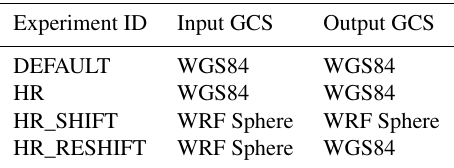
Figure 6. Flowchart for transforming and generating new model input data. Table 2. Shown below is the input and output GCS for the data used in each of the four analyses that will be